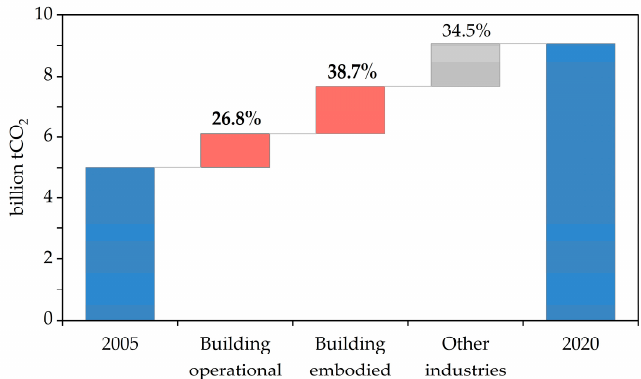
Figure 19. Emission contribution of the building sector to China’s total emissions.